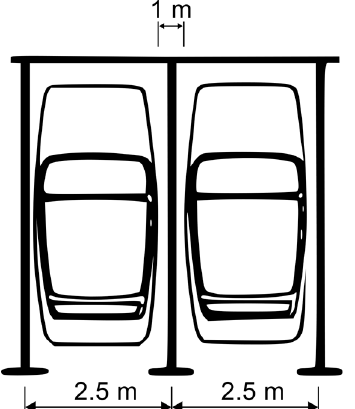
Figure 5. Clearance between parked vehicles.